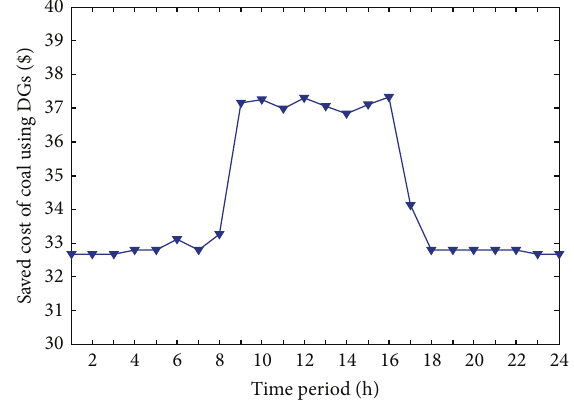
Figure 8: Hourly cost savings on coal consumption.